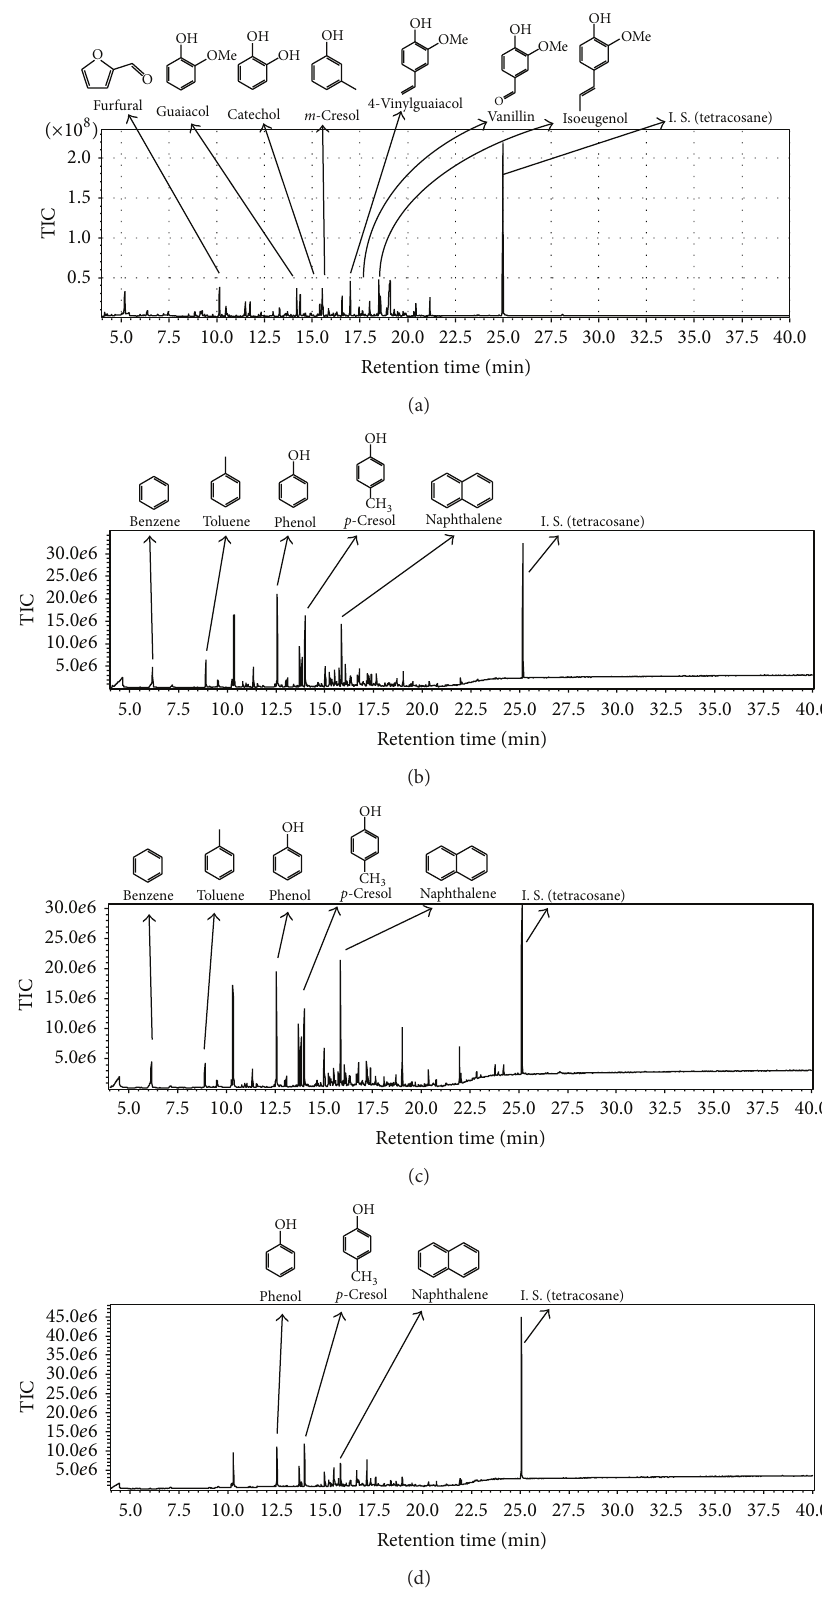
Figure8:TICofpyrolysisoilsobtainedfromofJapanesecedarwoodmeal/catalyst(1 : 1w/w)mixturespyrolyzedat500 ∘ C:(a)withoutcatalyst [10], (b) Fe 3 O 4 , (c) TiO 2 , and (d)